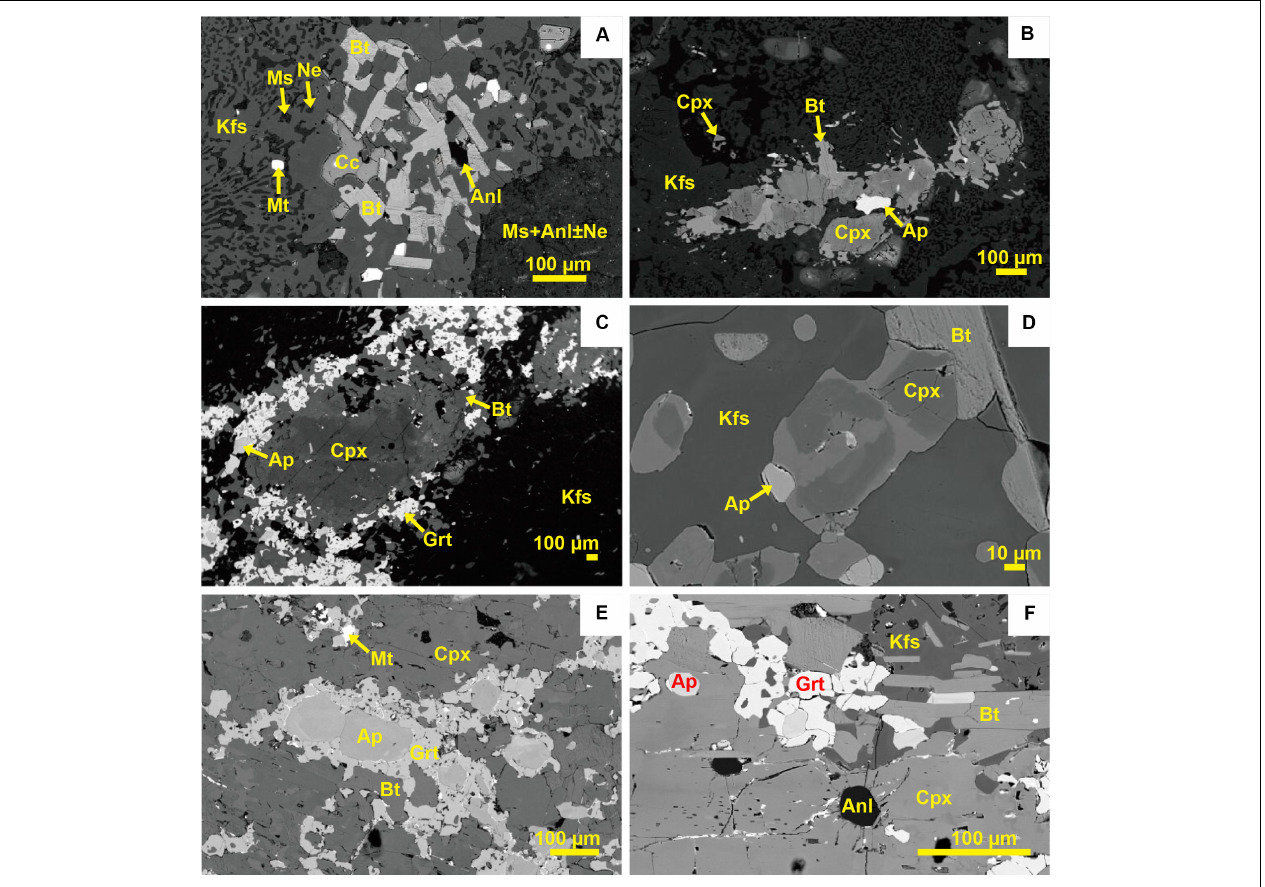
FIGURE 5 | Photos of pseudoleucite clinopyroxenite. (A) Calcite inclusion (BSE image). (B) Anhedral zoned clinopyroxene clusters as inclusions in pseudoleucite (BSE image). (C) Complex zonation of clinopyroxene in the matrix (BSE image). (D) A core of relics or clastic of clinopyroxene with visible zonation, rimmed also by zoned clinopyroxene (BSE image). (E) Apatite enclosed in garnets (BSE image). (F) Euhedral analcites in clinopyroxenes with expansion cracks (BSE image). Abbreviations are as